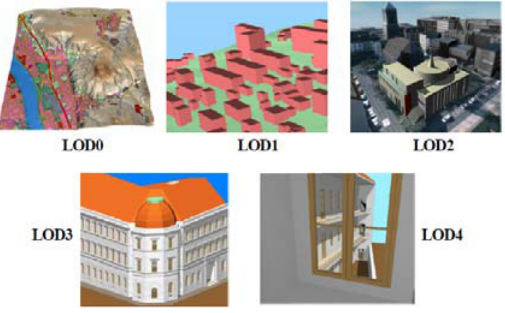
Figure 1. Levels of Details in CityGML (OGC 2012a)